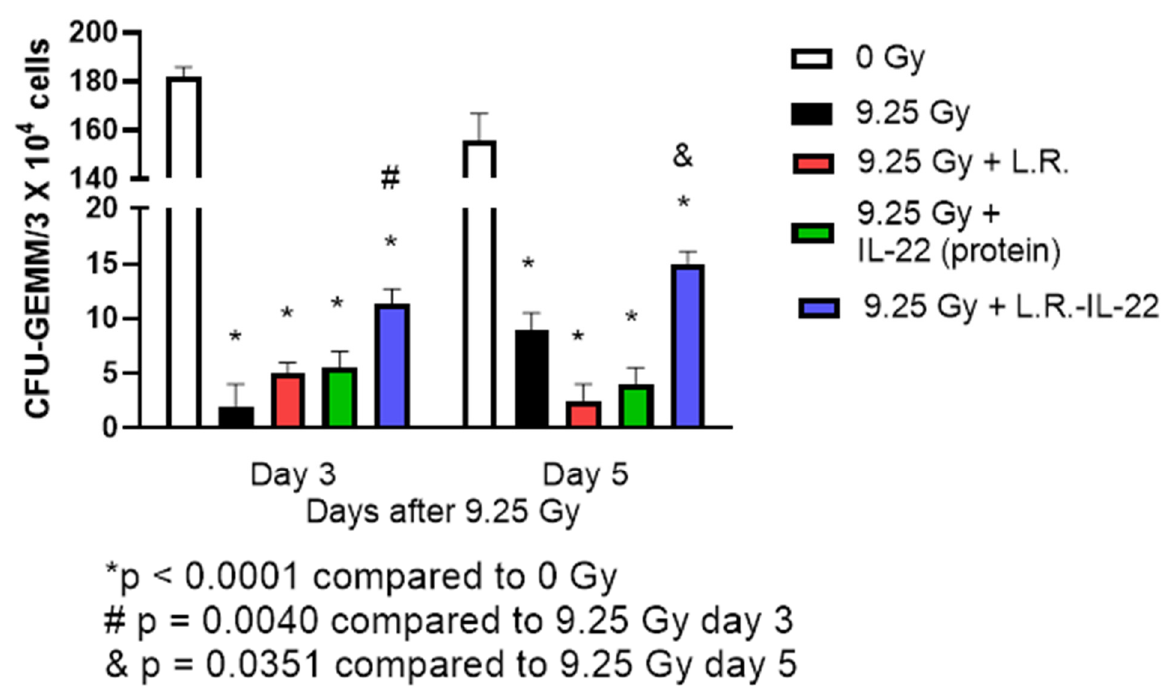
Figure 8. LR-IL-22 gavage at 24 h after 9.25 Gy TBI stimulates recovery of bone marrow hematopoietic progenitor cells. Marrow was removed from the femur of C57BL/6NTac mice ( n = 5) at day 3 or day 5 after 9.25 Gy TBI. Subgroups of mice received irradiation alone or irradiation plus gavage of 10 9 LR-IL-22 or 10 9 LR bacteria in 100 µ L saline or IL-22 protein at 0.1 mg/kg in 200 µ L saline intraperitoneal injection at 24 h after TBI. Marrow was prepared as single cell suspensions and plated at 5 × 10 4 or 1 × 10 5 nucleated cells in 0.8% methylcellulose containing medium supplemented with growth factor G-CSF, erythronectin, GM-CSF in McCoys 5A medium plus 15% fetal bovine serum as published (37). Colonies of ≥ 50 cells were scored at day 14 ( n = 3 plates per point, n = 5 mice per point per group. The * symbol represents the Day 3 irradiation groups to the Day 3 control or the Day 7 irradiation groups to the Day 7 0 Gy group. The # sign is the p value of the Day 3 9.25 Gy + LR-IL-22 compared to the 9.25 Gy group on Day 3. The & symbol represents the p value comparing Day 7 9.25 Gy + IL-22 group to the 9.25 Gy group on Day 7. The data is presented as mean plus standard error of the mean.